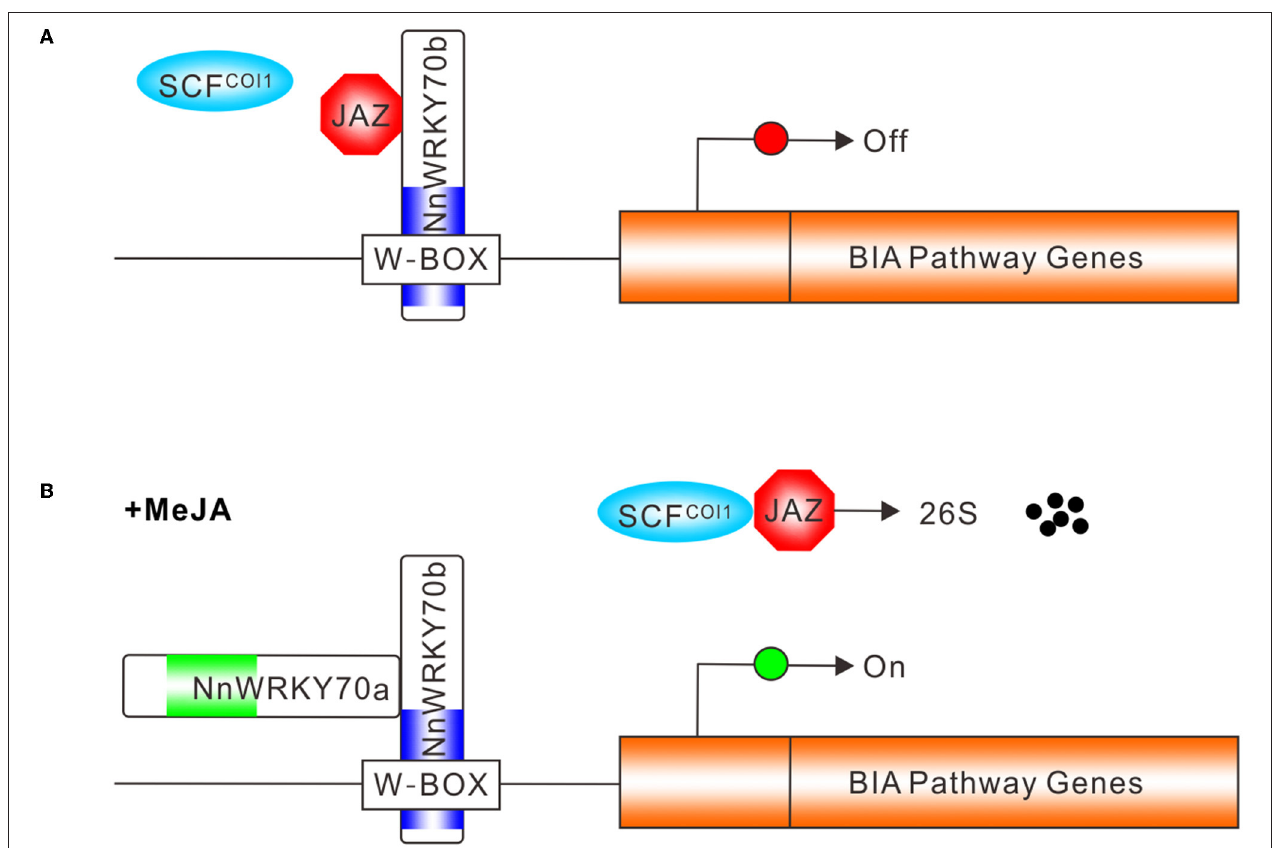
FIGURE 8 | Simplified model of NnWRKY70b TF action in regulating lotus BIA biosynthesis. (A) In the absence of JA, JAZ proteins bind to NnWRKY70b and repress its activity, resulting in the inactivation of BIA pathway genes in the lotus. (B) In the presence of JA, the SCF COI1 complex facilitates the ubiquitin-26S mediated JAZ degradation. The NnWRKY70b protein is then released and forms protein complexes with another group III WRKY proteins to positively regulate the BIA pathway genes, through binding the W-box cis -element in their promoters. Blue and green boxes represent WRKY DNA binding domains in NnWRKY70a and NnWRKY70b,